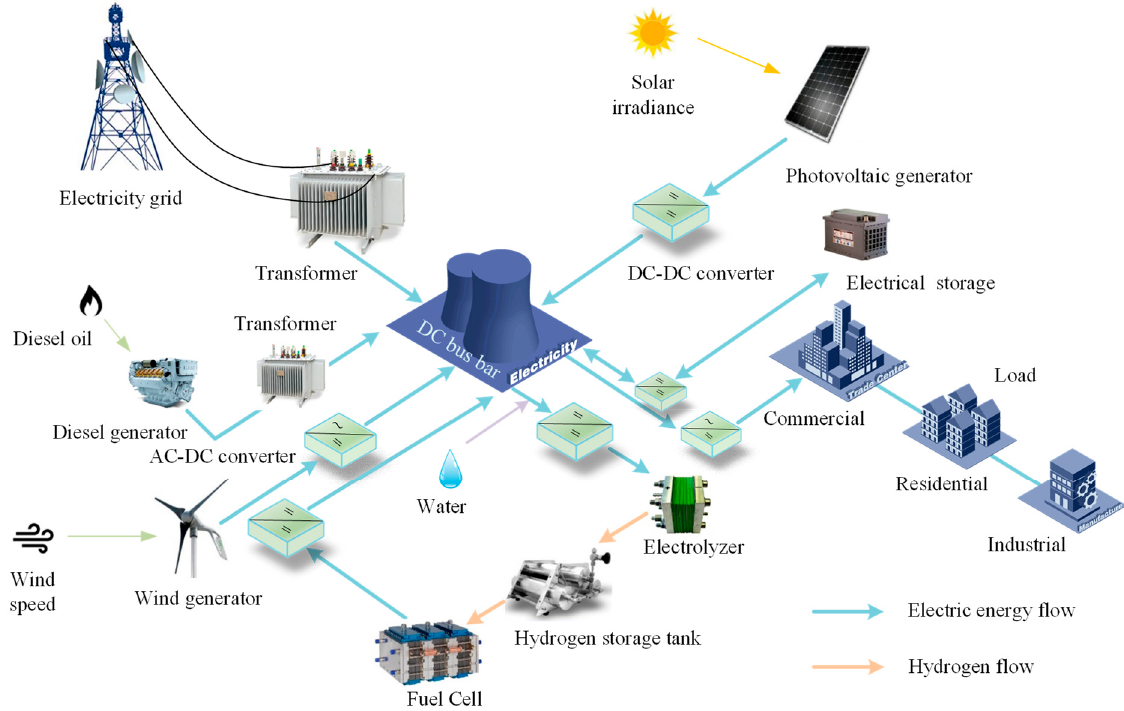
Figure 1. Microgrid structure.